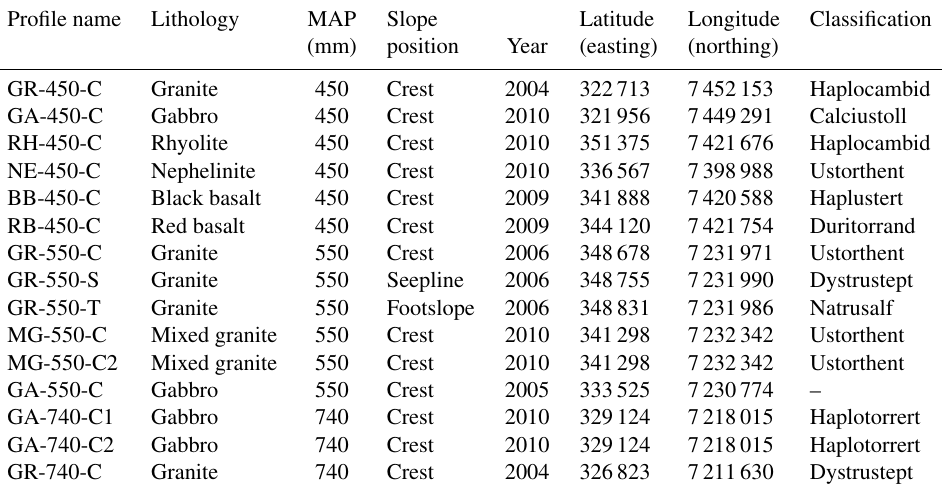
Table 1. Profile names used in the text, parent material lithology, mean annual precipitation (MAP), year of collection, locations, and classification of the soil profiles used for this